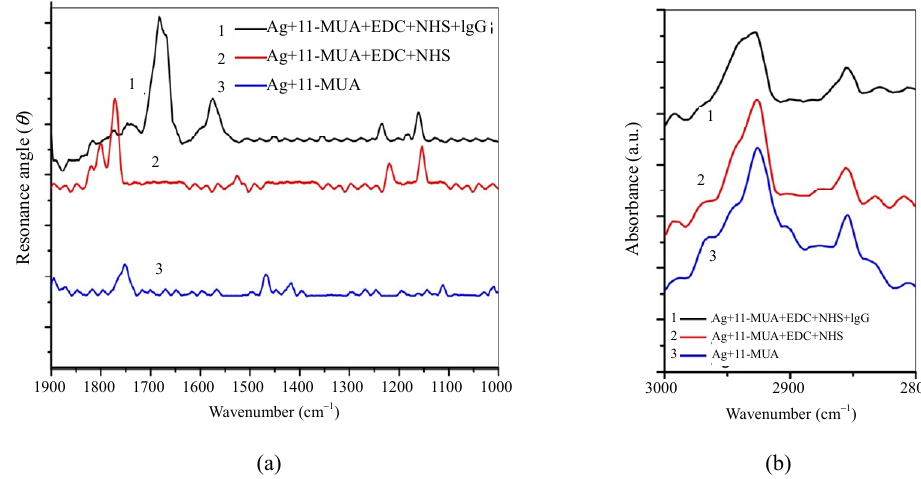
Fig. 4 FTIR spectra of the sensor surface before and after antibody